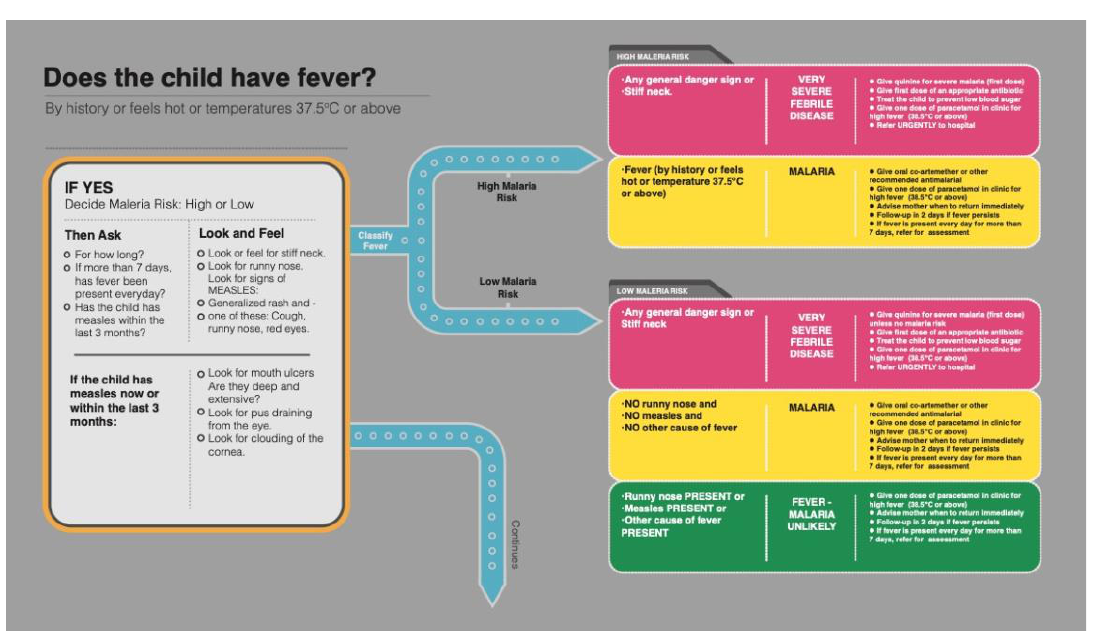
Figure 2. Fever algorithm from the 2008 IMCI chart booklet. . Reprinted from Integrated Management of Childhood Illness Chart Booklet , 2nd ed., WHO and UNICEF, page 4, copyright 2008. Accessed 1 October 2018.